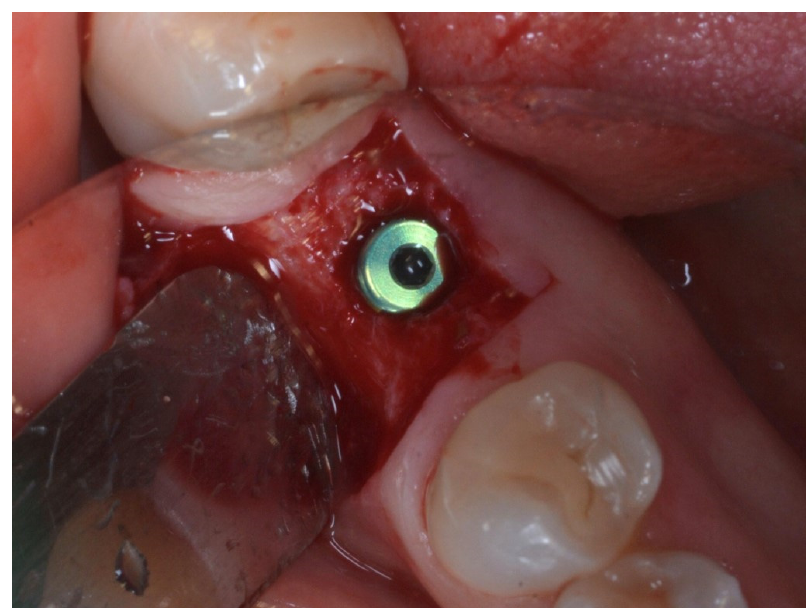
Figure 15. Intraoral view of the healing abutment covering the fixture after surgery.